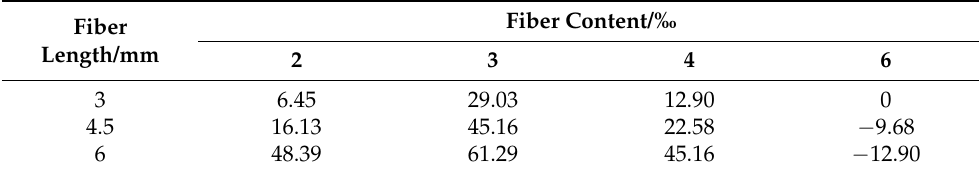
Table 7. Reinforcement effect coefficient of splitting strength of